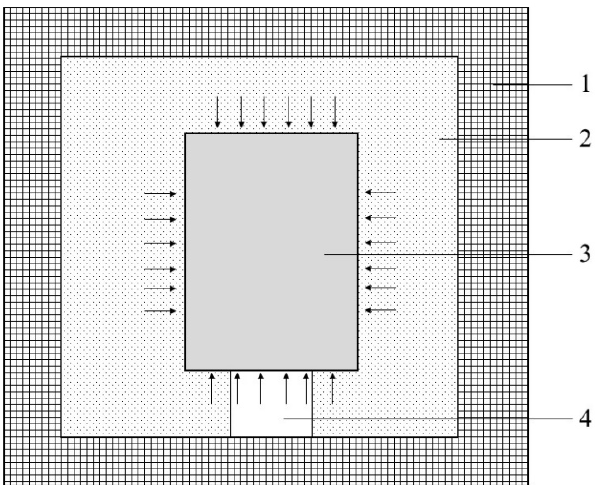
Figure 14. SEM image of the spray-formed alloy ingot. ( a ) magnified 200 times, ( b ) magnified 500 times.